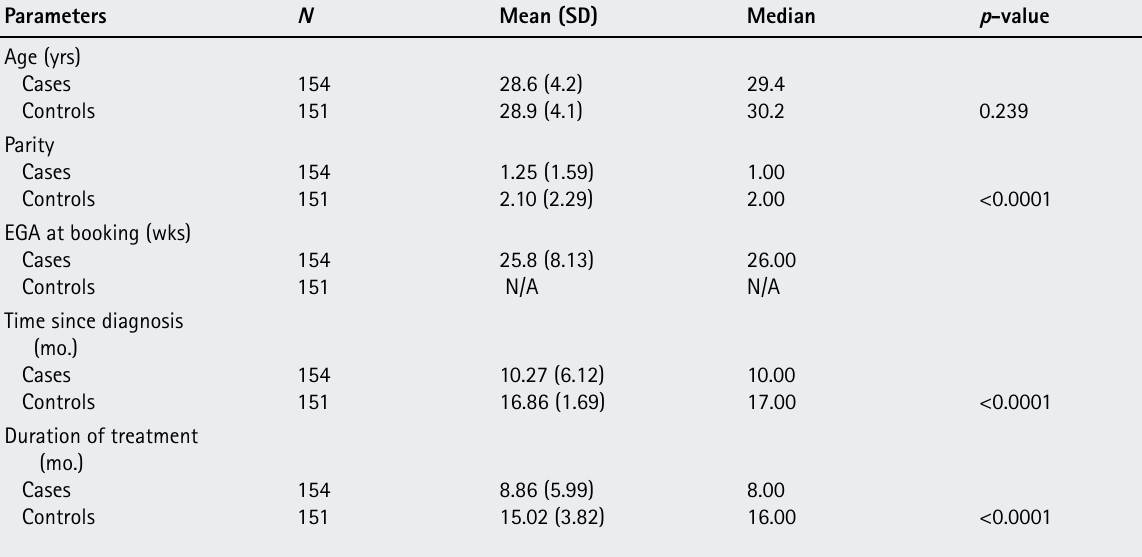
taBle i. coMPariSon oF tHe SUMMarY StatiSticS oF tHe Socio-DeMograPHic ProFile, DUration oF DiagnoSiS anD treatMent oF caSeS v.